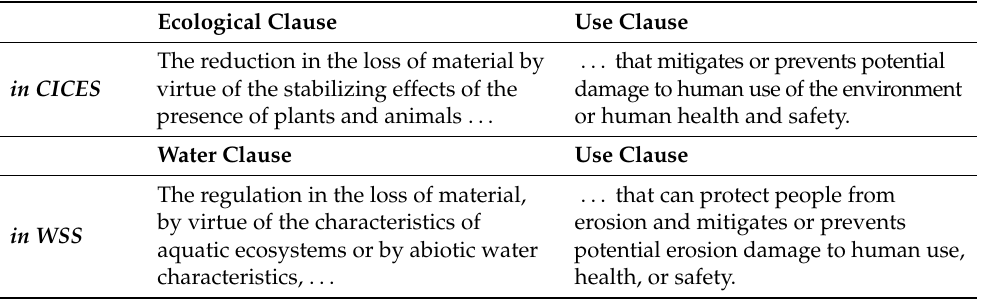
Table 4. Comparison of clause descriptions for service class erosion control (code: 2.2.1.1) in CICES and analogously in the water system services list for Sweden. The water clause corresponds to the ecological clause in CICES. The term use clause remains